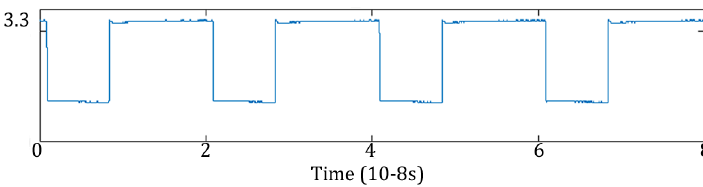
Figure 21. PWM signal generated in SHIL Simulation for buck-boost permanent condition ( d =